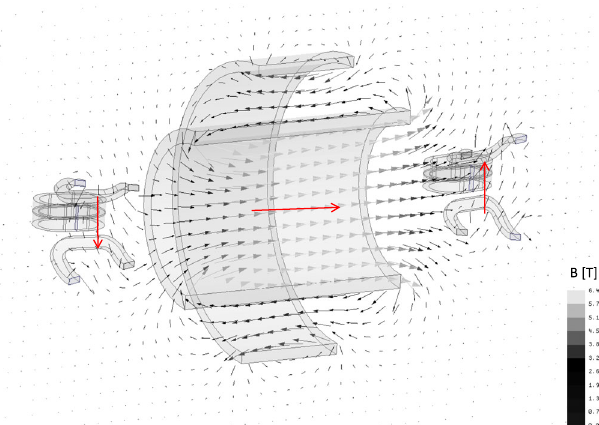
FIG. 3. Magnetic field map of forward dipoles in combination with twin solenoid. The dipoles are arranged in an up-down configuration. The red arrows indicate the solenoidal and dipole field orientations. It is clear that the dipoles are located very close to the twin solenoid, so that the stray field from the twin solenoid on the dipole conductor is as high at 1 T.